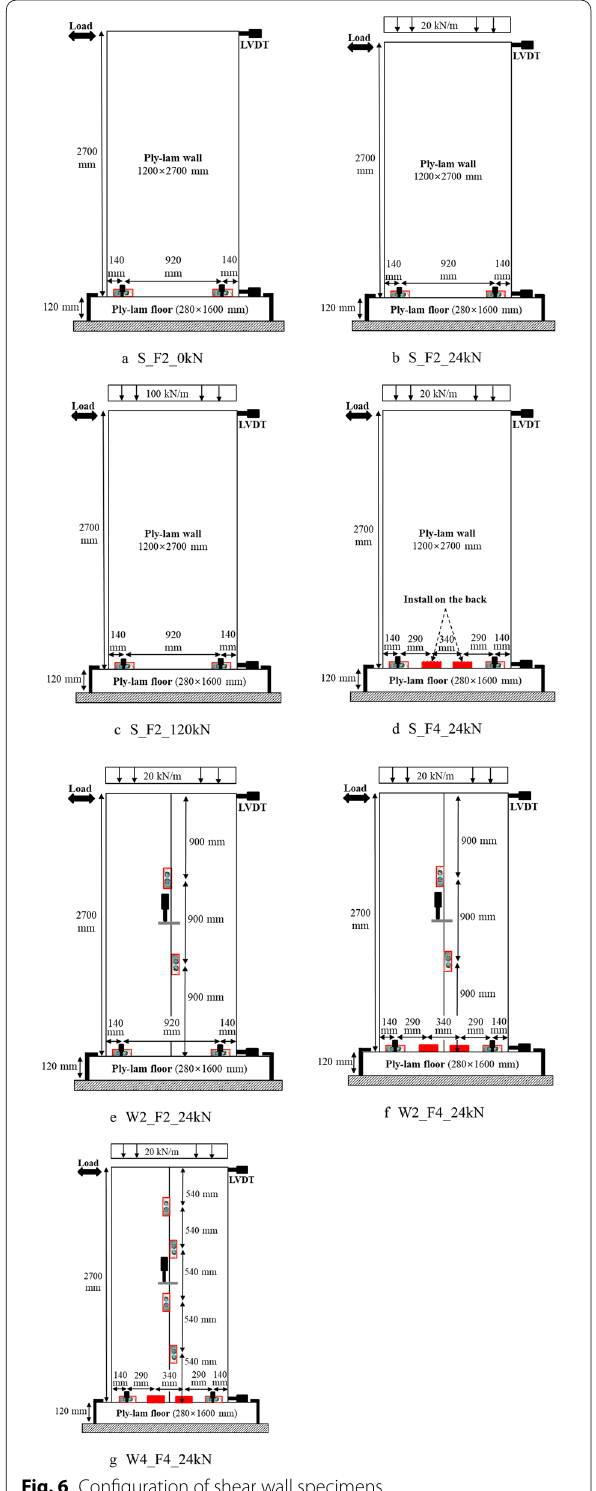
Fig. 6 Configuration of shear wall specimens